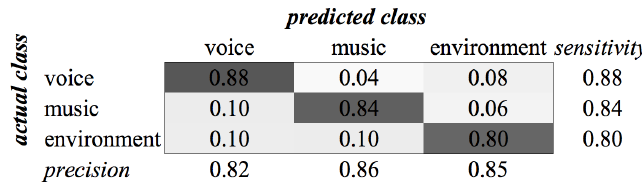
Figure A2. KHMM confusion matrix of category Global for MFCC feature type.